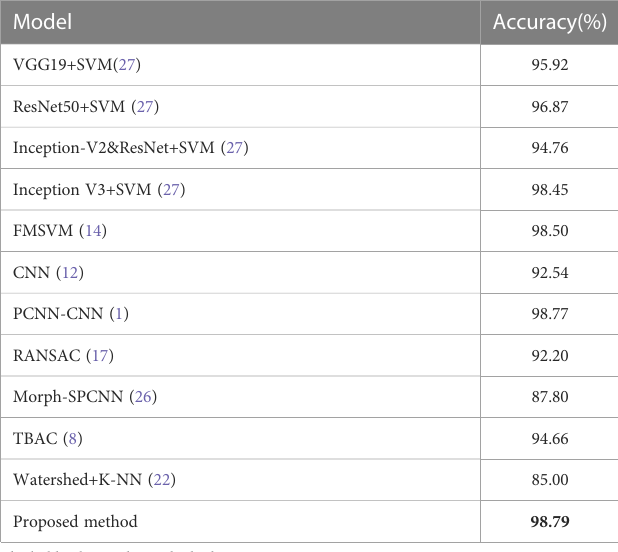
The bold values indicate the highest accuracy.